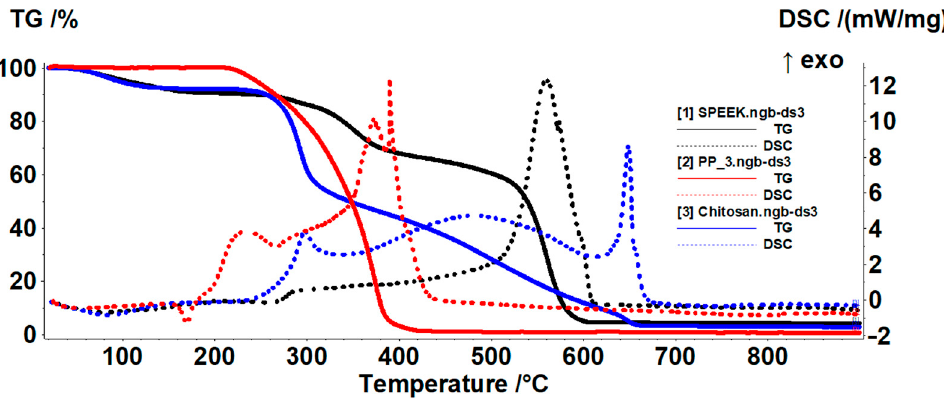
Figure 9 . Comparative thermal diagrams of the three membrane